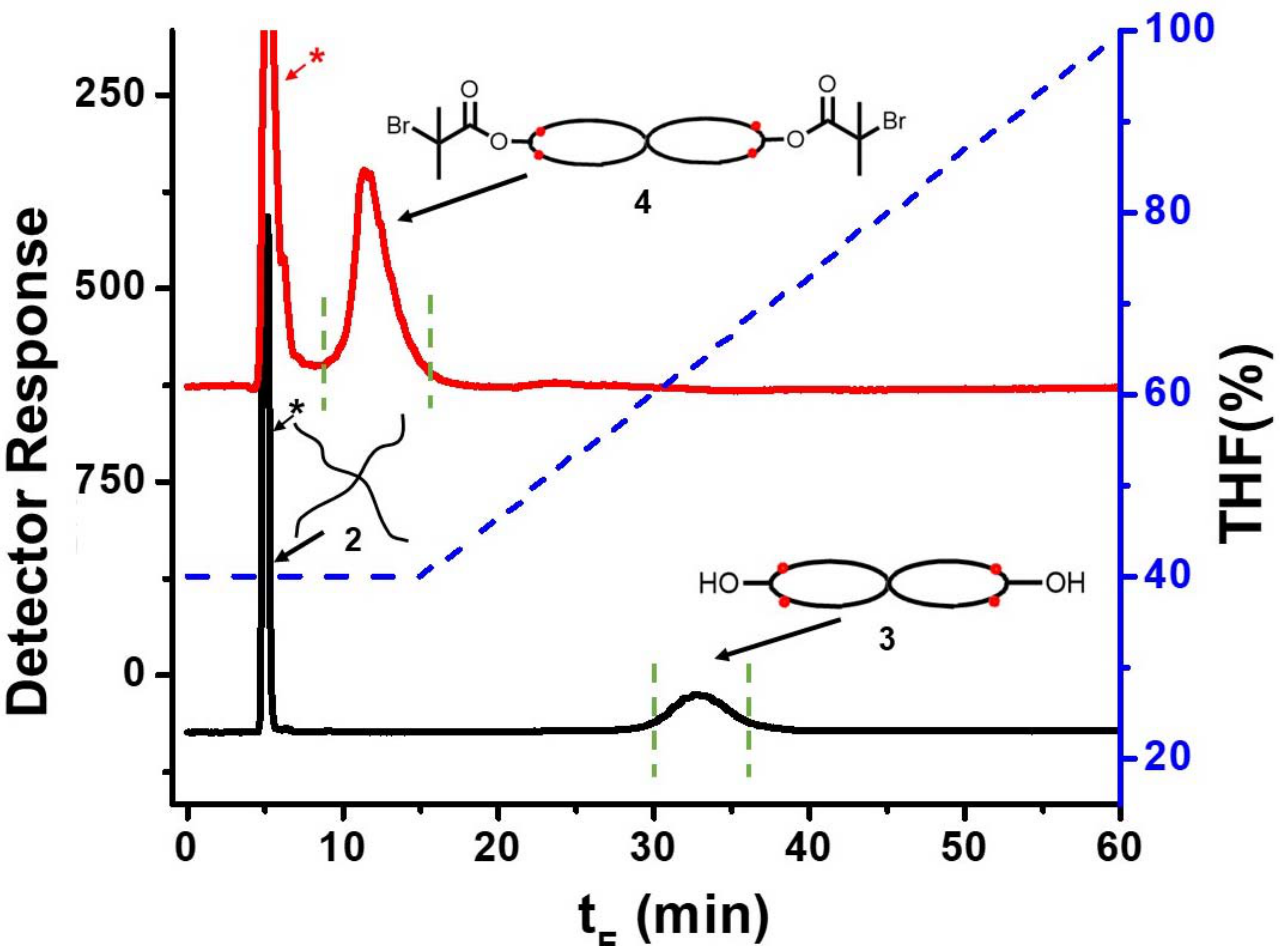
Figure 4. MPLC analysis of spirocyclic polystyrene (black line) and spirocyclic macroinitiator (red line). * indicates solvent peak. Precursor (2, tetra-arm PS-N 3 ) is overlapped with solvent (see black line).